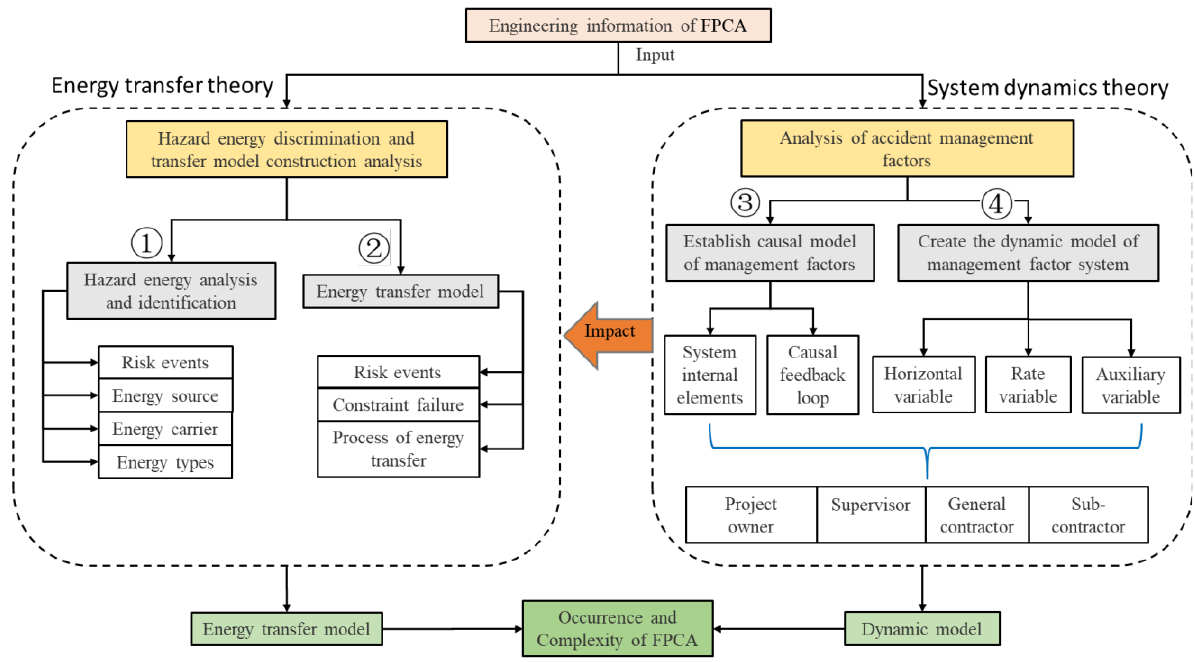
Figure 4. The hybrid approach for accident analysis of the FPCA.